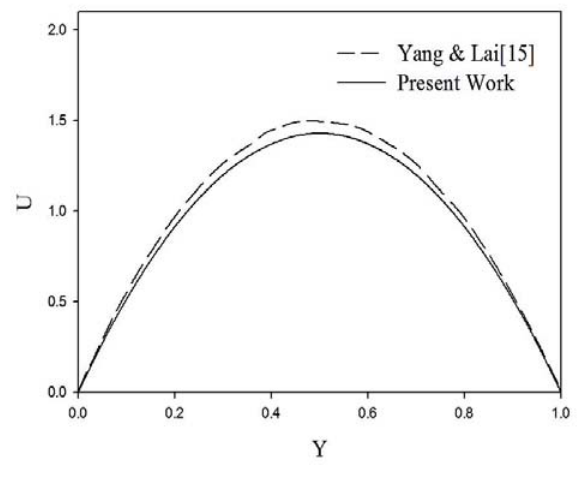
Fig. 4. Comparison of velocity profile in fully-developed laminar nanofluid flow in a channel with Re=16 and 0.04 φ = .